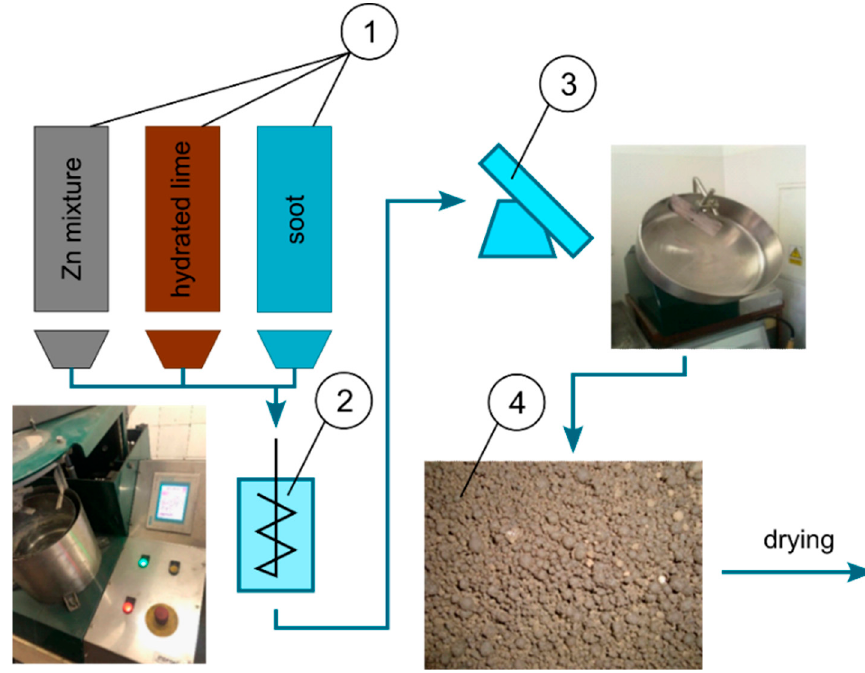
Figure 3. Diagram of the granulate preparation system used in the research: 1—input material feeding system; 2—intensive mixer; 3—plate mixer; 4—granules.